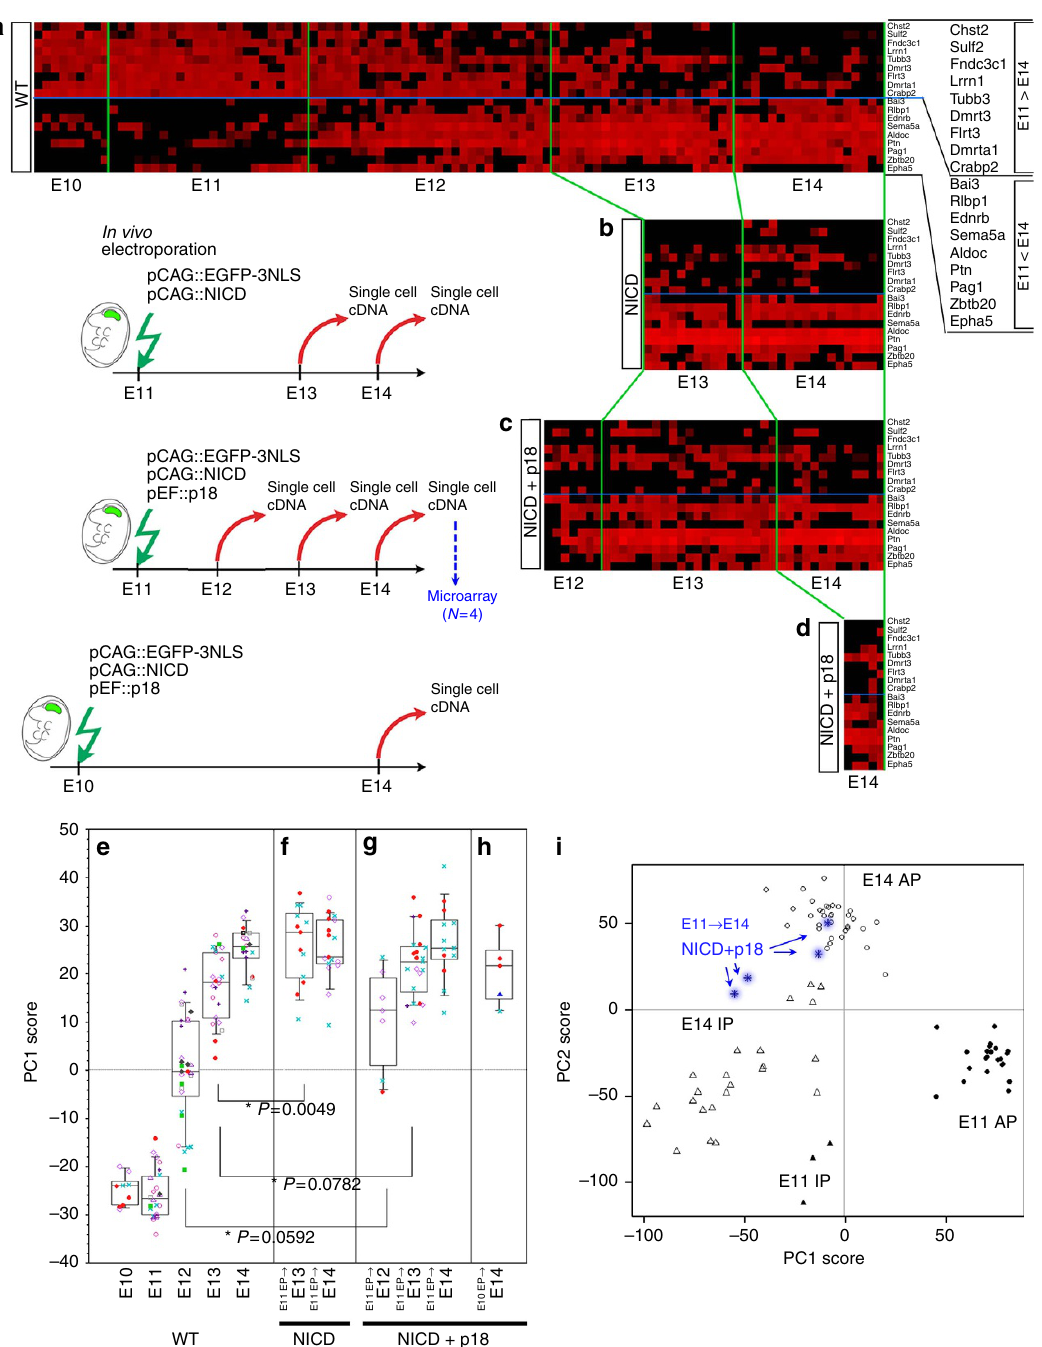
Figure 4 | Neither Notch activation nor cell-cycle arrest stops the temporal change in gene expression of APs. ( a – d ) Expression levels of 18 temporal- axis genes in single APs examined by qPCR. [40-Ct] values after normalization by Gapdh range from high (red) to low (undetectable) (black) in these heat maps. One column indicates a single AP. ( a ) Single-cell cDNAs from E10–14 wild-type APs. ( b – d ) NICD ( b ), or NICD and p18 ( c ) were overexpressed along with EGFP at E11; the genes were introduced by in vivo electroporation. After 1 day (E12), 2 days (E13) or 3 days (E14), single-cell cDNAs were generated from EGFP þ cells. APs were selected as Ttyh1 þ /Tbr2 (cid:2) . ( d ) NICD and p18 were overexpressed along with EGFP at E10; the genes were introduced by in vivo electroporation. After 4 days (E14), single-cell cDNAs were generated from EGFP þ cells. APs were selected as Ttyh1 þ /Tbr2 (cid:2) . ( e ) PC1 scores of single APs calculated from the expression levels of 18 temporal-axis genes. PCA was performed on normalized [40-Ct] values of 18 genes in a mixture of E10–E14 APs ( N ¼ 102), and the PC1 scores of single APs were plotted at each developmental stage. One dot indicates one AP, and cells from the same embryos are indicated by the use of the same symbols in each stage. See also Supplementary Fig. 10. ( f – h ) PC1 scores of NICD - expressing ( f ), or NICD/p18 co-expressing APs ( g , h ) were calculated using Component 1 obtained from PCA on wild-type APs ( e ). ( i ) PCA was performed using the microarray data from single-cell cDNAs from NICD/p18-overexpressing cells (E11 electroporation, E14 sampling, N ¼ 4, blue) and E11 and E14 progenitor cells (APs þ IPs, N ¼ 79; 17,192 probe sets). Each symbol represents one cell. The two plots for the NICD/p18 cells are located among the plots for the E14 APs. The other two plots for the NICD/p18 cells are located near the plot for the E14 IPs, which may reflect the effect of p18 on differentiation (Fig. 5b). See also Supplementary Fig.